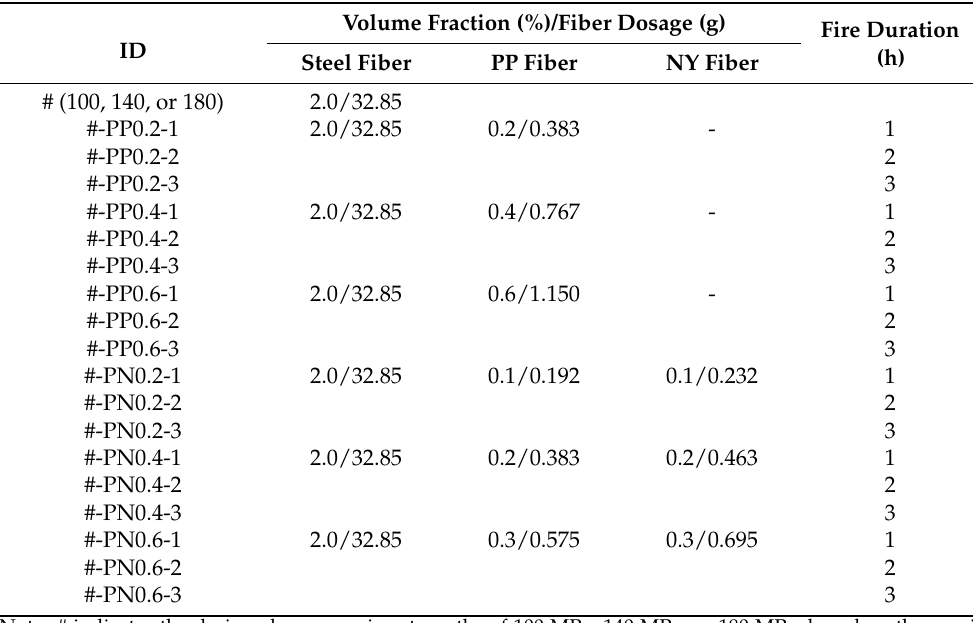
Table 4. Summary of experimental